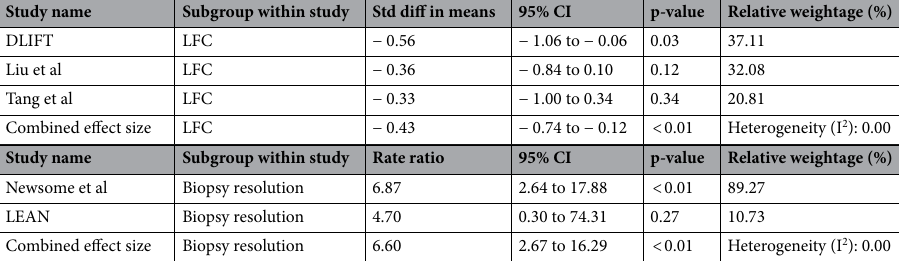
Table 3. Effect of GLP1-RA versus control on liver fat content (a), and biopsy resolution (b). CI confidence